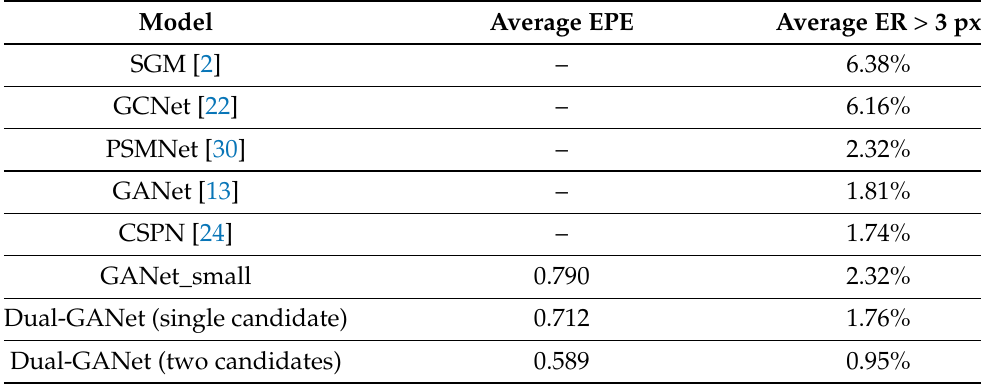
Table 2. Comparisons of the related methods and the proposed models using the KITTI2015 dataset.